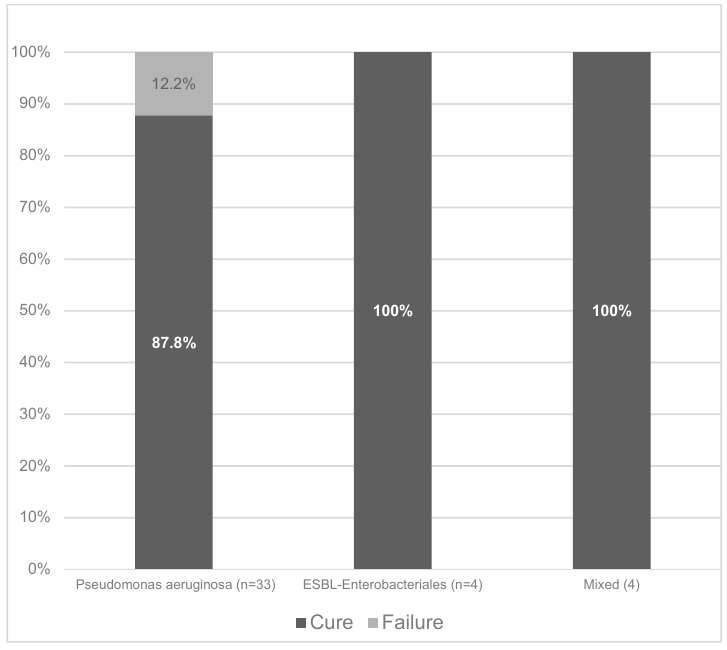
Figure 2 . Clinical cure rates according to the different causative agents.